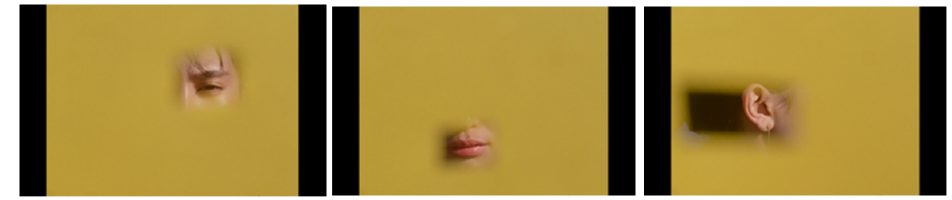
Figure 10. Autofiction